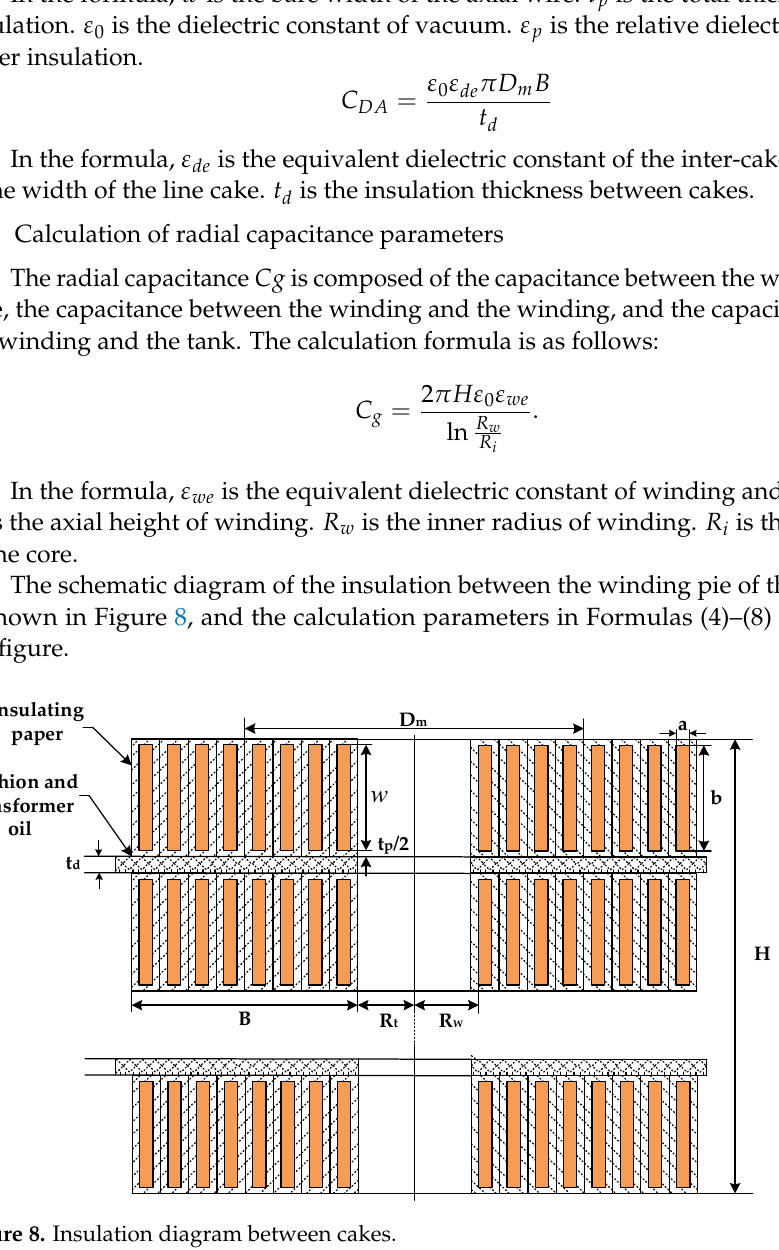
Table 3. Structural dimension parameters of high voltage windings.